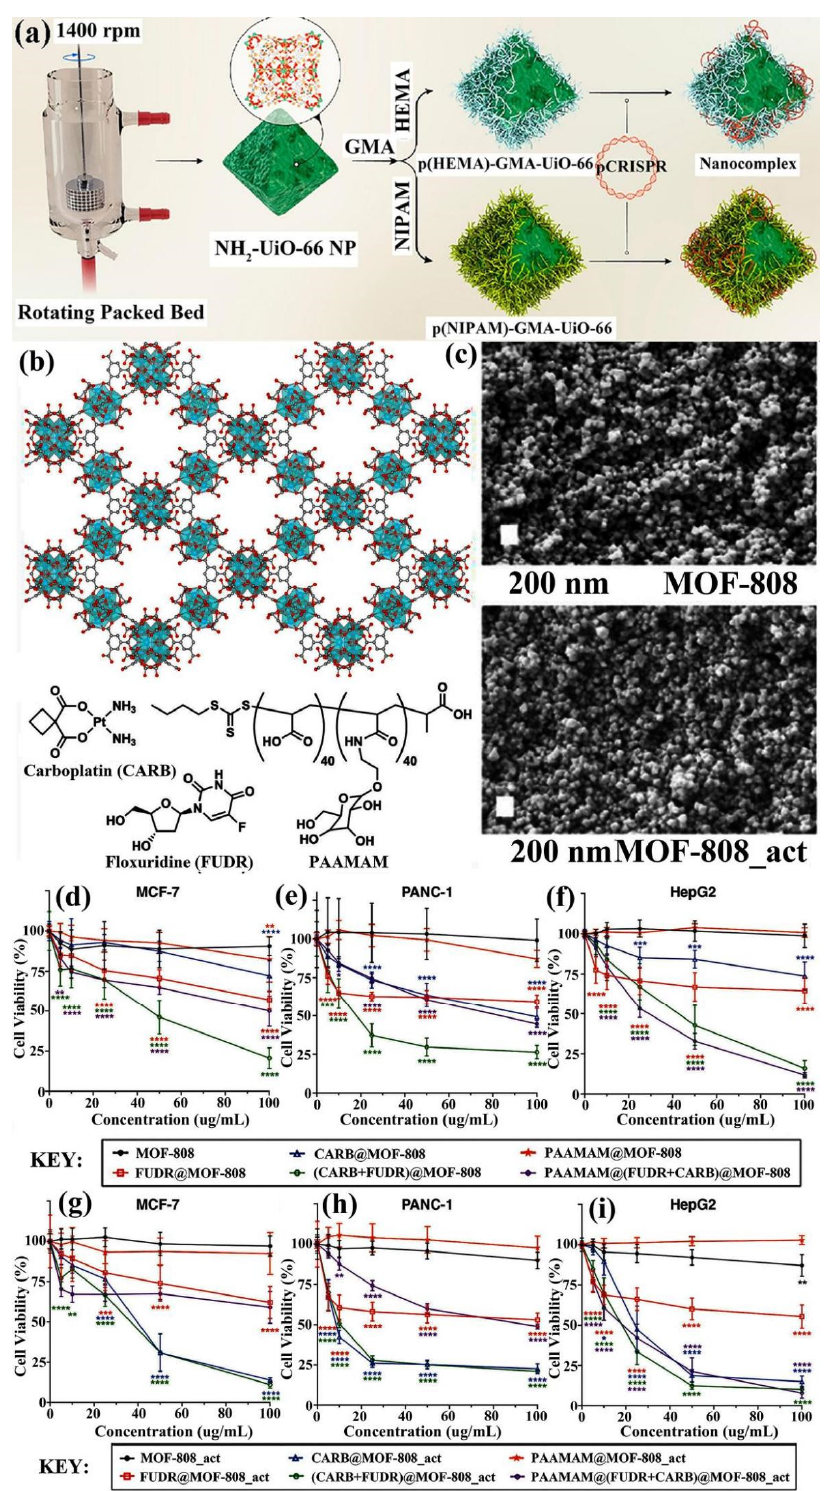
Figure 2. ( a ) Polymer-coated MOFs with pCRISPR. Reproduced with permission from Ref. [71], copyright (2021) the American Chemical Society. ( b ) Structure and morphology of MOF-808 and MOF-808_act. ( c ) Scanning electron micrographs of the nanoparticulate samples (scale bars 200 nm). ( d – i ) Cell viability. Reproduced with permission from Ref. [72] copyright© 2022 The Authors. Published by the American Chemical Society. ( p ≤ 0.01 (**), p ≤ 0.001 (***), and p ≤ 0.0001